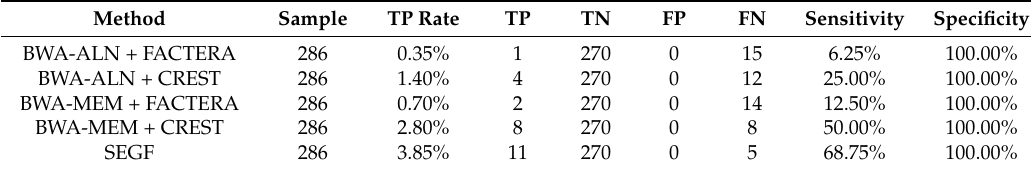
Table 3. Comparison of ALK–EML4 fusion detection results for clinical